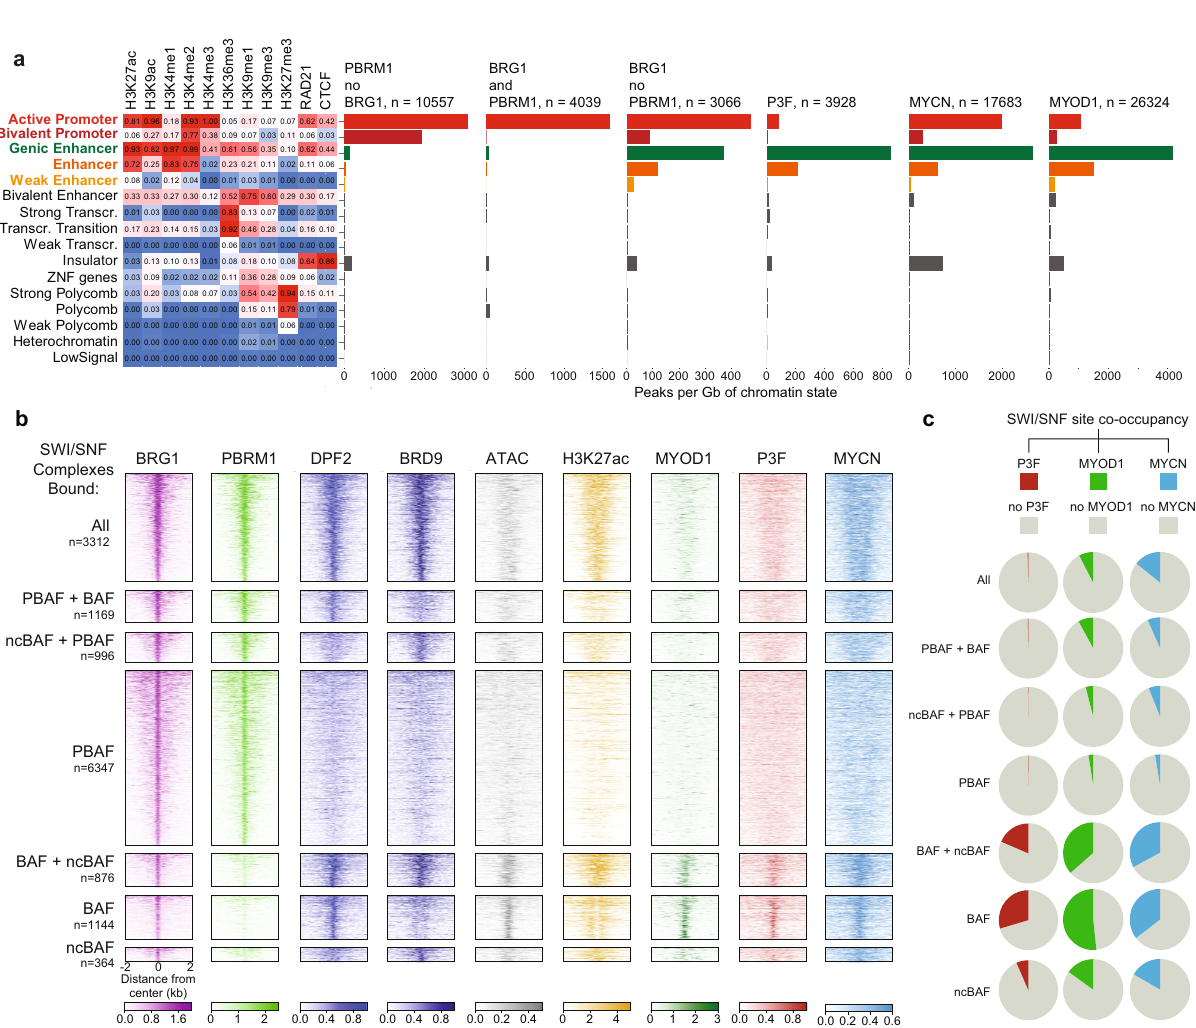
Fig. 4 RMS-BAF complexes bind core regulatory circuitry. a Chromatin states in FP-RMS cells using ChIP-seq data for histone marks plus CTCF and RAD21 using hidden Markov modeling algorithm chromHMM are ranked for association with binding of PBRM1 alone, PBRM1 together with BRG1 or BRG1 alone, as well as PAX3-FOXO1, MYCN, and MYOD1 genomic binding. b Heat maps displaying peak distribution of BRG1, PBRM1, DPF2, and BRD9. Subtype complexes are de fi ned as follows; BAF; BRG1 and DPF2, PBAF; BRG1 and PBRM1, ncBAF; and BRG1 and BRD9. Additionally, H3K27ac deposition, as well as MYOD1, P3F, and MYCN binding are given for BAF complex subtype speci fi c sites. Number of detected peaks are indicated on the left. c Pie-charts illustrating degree of co-occupancy of BAF complex subtype bound loci with PAX3-FOXO1, MYOD1, and MYCN. Accession details for ChIP-seq data (GSE162052) can be found in the data availability